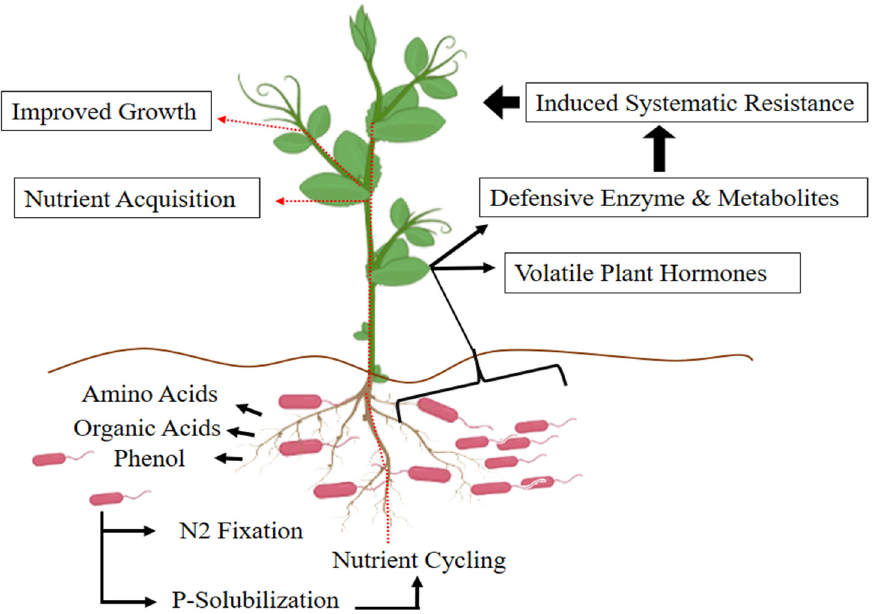
Figure 2. Mechanisms employed by rhizobacteria for increases in plant growth and tolerance to abiotic stresses. Rhizobacteria improve nutrient content and nutrient cycling and help plants to withstand harsh environmental